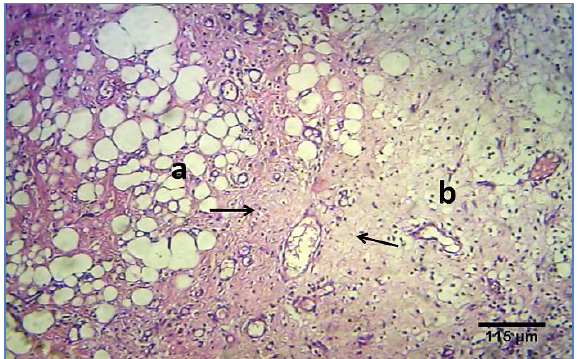
Figure, 5: Histopathological section in the colon and omentum of animal, shows marked fibrous connective tissue bundles (Arrows) in the omentum (a) and tunica serosa (b) also adhesion formation between them. H and E stain (grade, 3), 7thday post-operation, in group A.